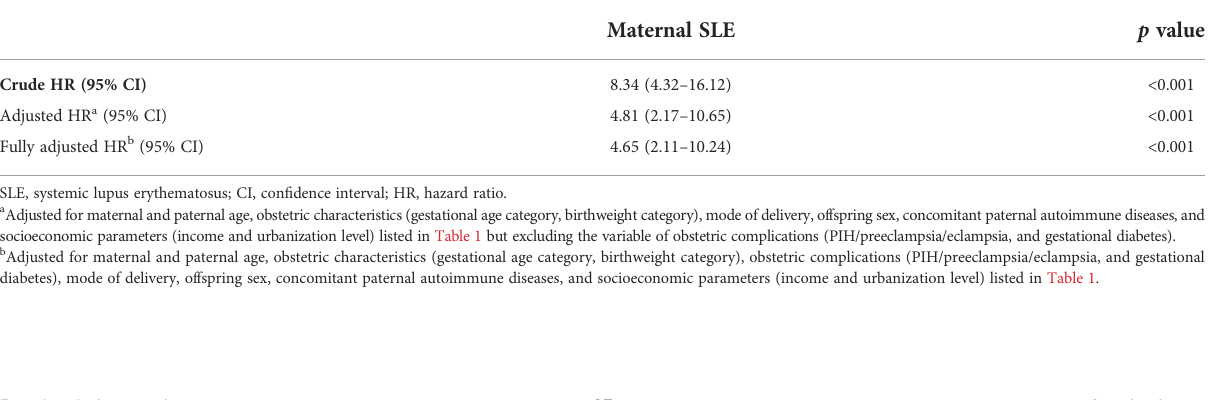
TABLE 3 Crude and adjusted hazard ratios of maternal SLE leading to early-onset childhood